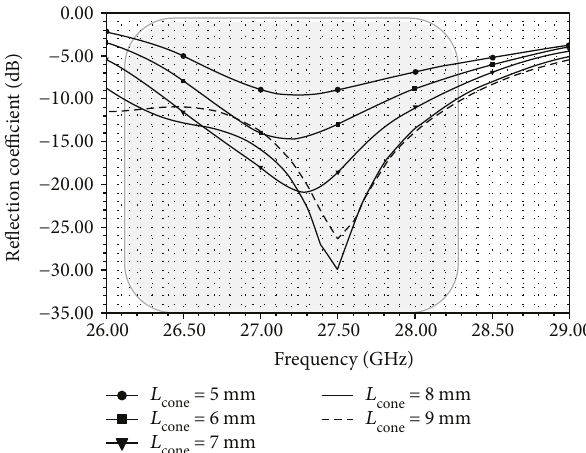
Figure 3: Re fl ection coe ffi cient of the conical horn as a function of length.